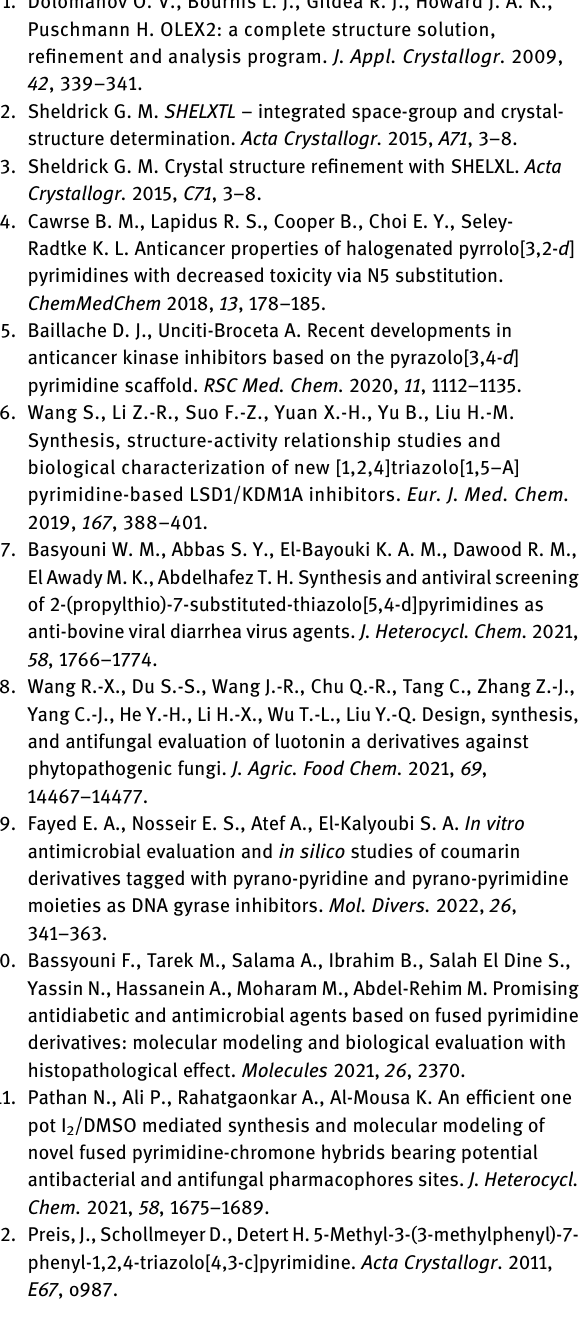
Table  : Fractional atomic coordinates and isotropic or equivalent isotropic displacement parameters (Å 